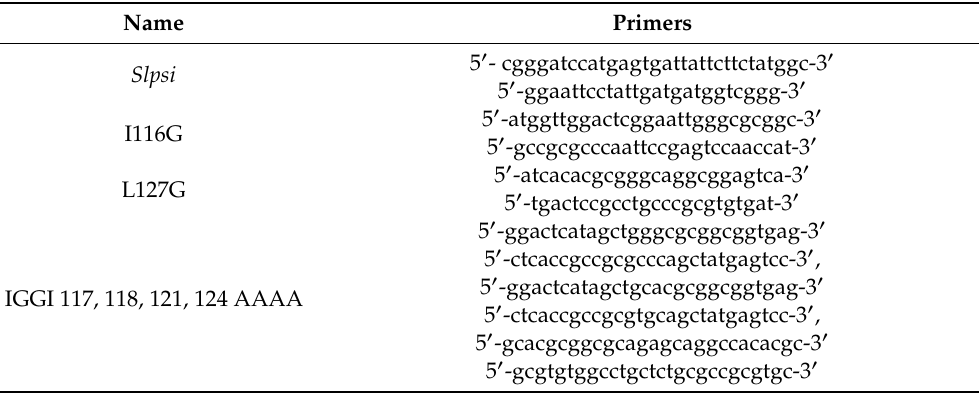
Table 3. Primer sequences of modifications on